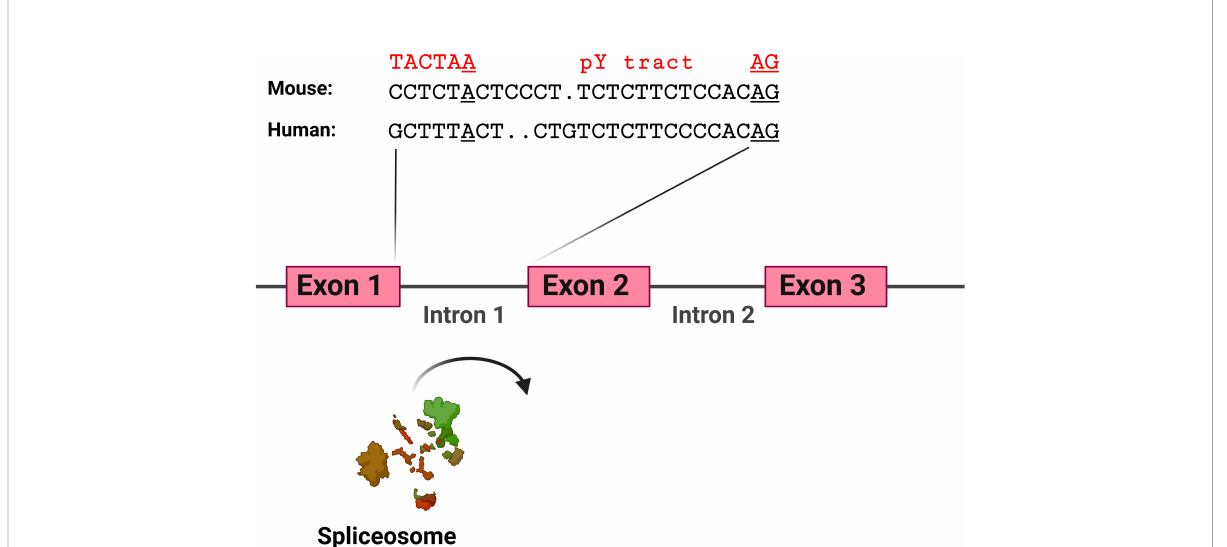
FIGURE 6 MyD88 intron 1 has relatively weak splicing regulatory sequences. Depicted are the sequences at the 3 ’ end of intron 1 in mouse and human MyD88. Sequences involved in facilitating exon 2 inclusion include the AG dinucleotide at the 3 ’ end of the intron, the polypyrimidine (pY) tract upstream of the AG dinucleotide, and the branch point sequence [identi fi ed for human MyD88 in (132)] including the branch point adenosine residue underlined. In red above the branch point is a strong branch point sequence (the reverse complement of the sequence in the U2 snRNA). Figure created with